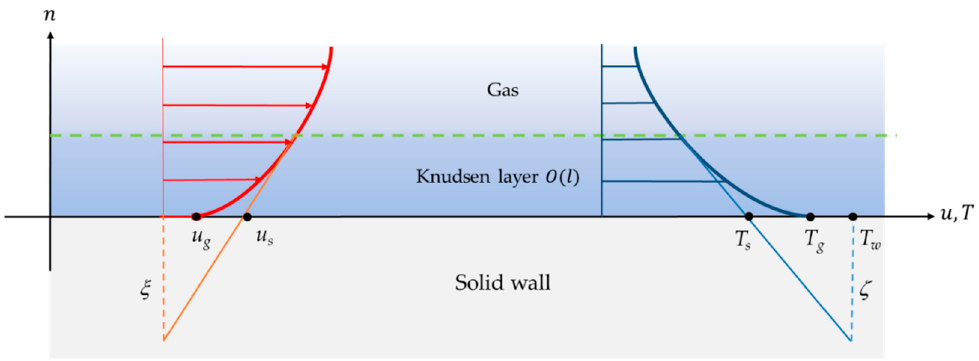
Figure 2. Schematic depicting velocity slip and temperature jump at the wall .